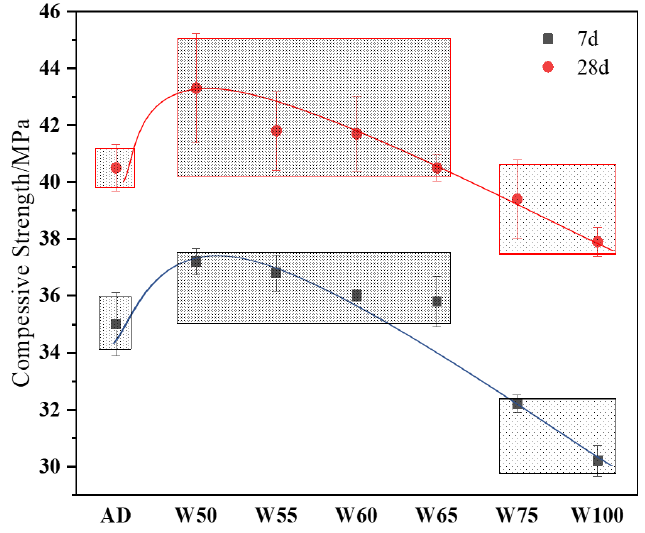
Figure 9. The compressive strength of recycled concrete at 7 d and 28 d.